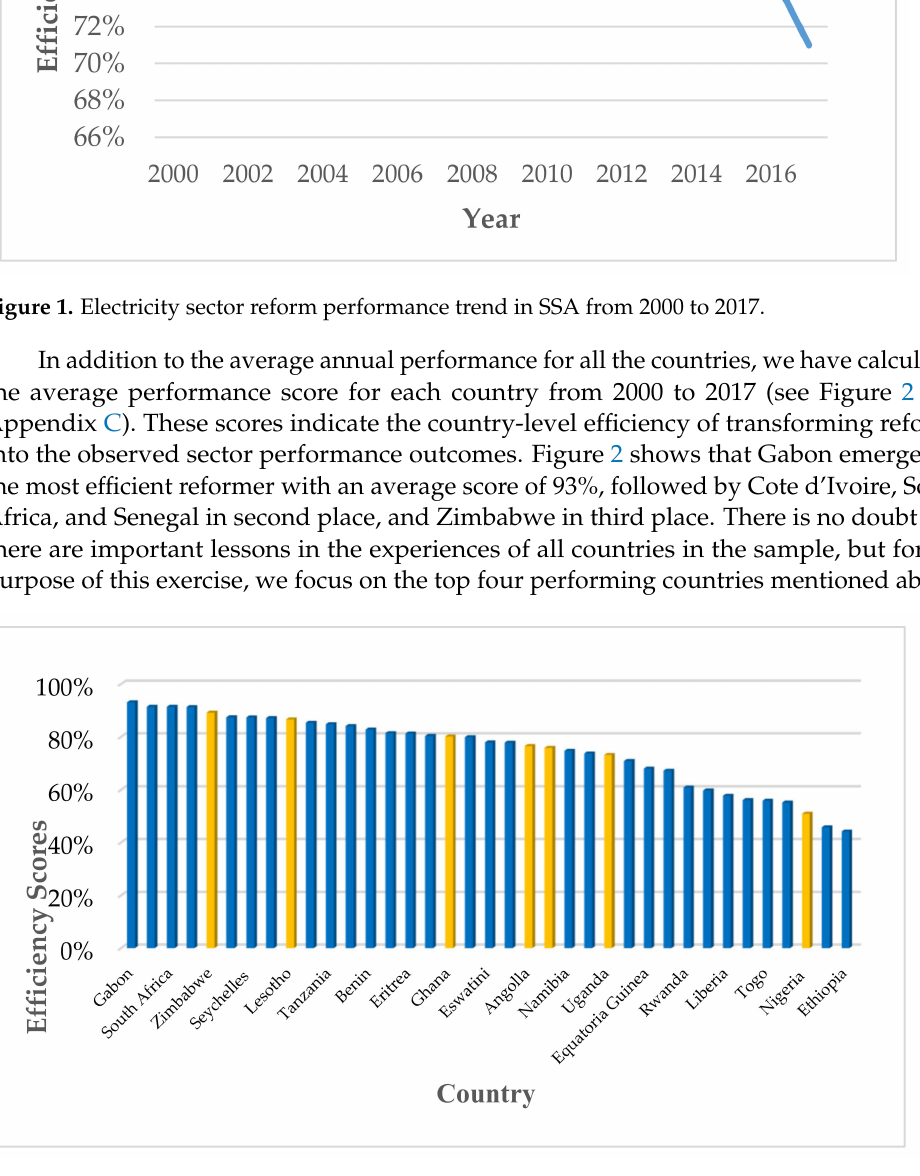
Figure 2. Average efficiency scores of SSA countries (2000–2017). Note: Countries with unbundled electricity systems are presented in